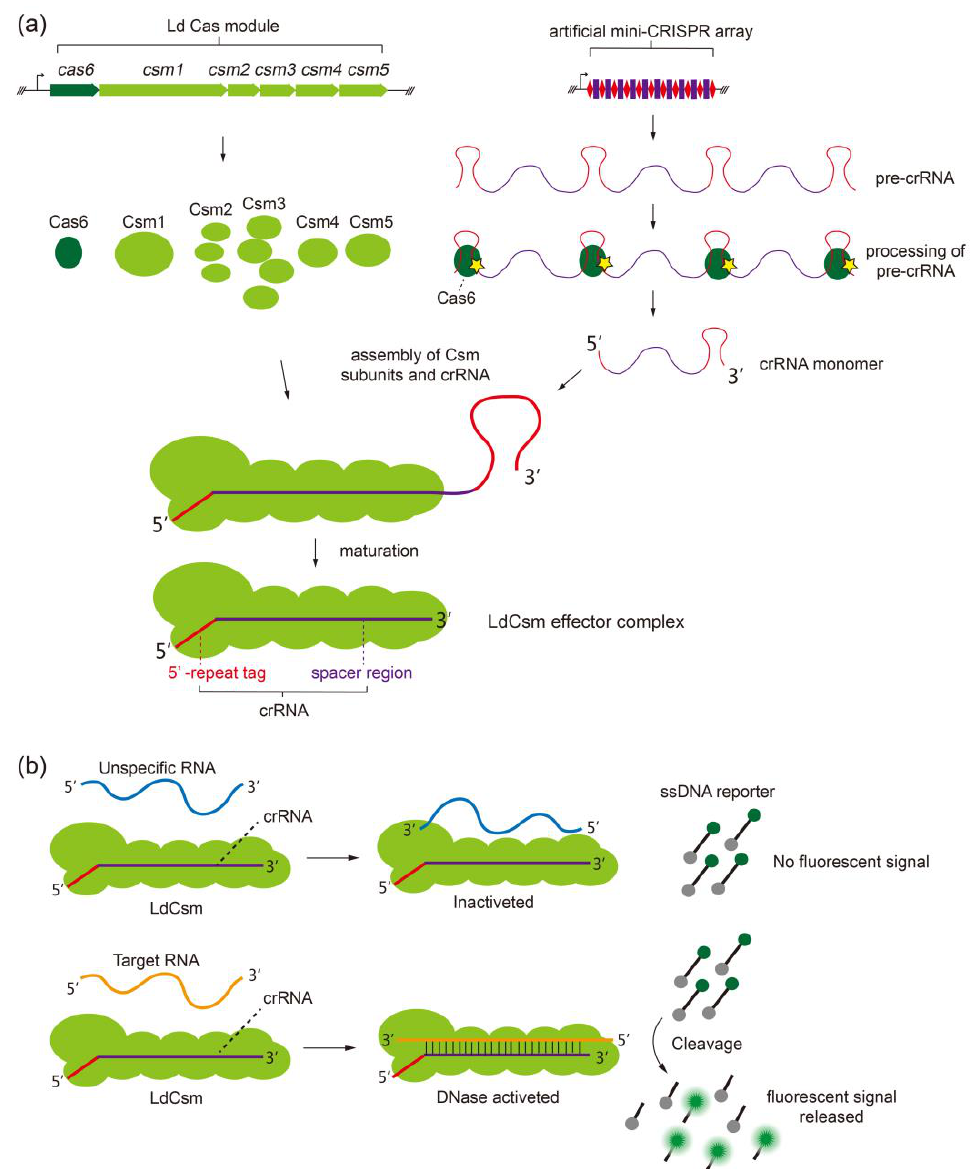
Figure 1. Rationale of the LdCsm-based RNA detection. ( a ) Schematic of the expression of the LdCsm system and the assembly of the LdCsm effector RNP complex. ( b ) Schematic of the LdCsm-based RNA detection reaction. Target RNA binds to the LdCsm RNP complex and activates the collateral DNase hosted by the Cas10 HD domain, an activity that cleaves the fluorescence-quenched ssDNA reporter (5 (cid:48) -FAM labeled and 3 (cid:48) -BHQ1 labeled ssDNA substrate), releasing fluorescence signals to be detected and recorded by fluorometry. RFU: relative fluorescence